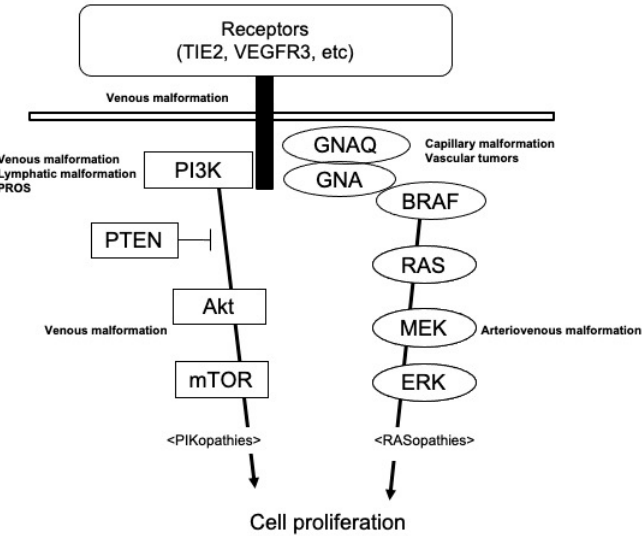
Figure 1. Diagram illustrating signaling pathways involved in the pathogenesis of vascular anoma- lies.